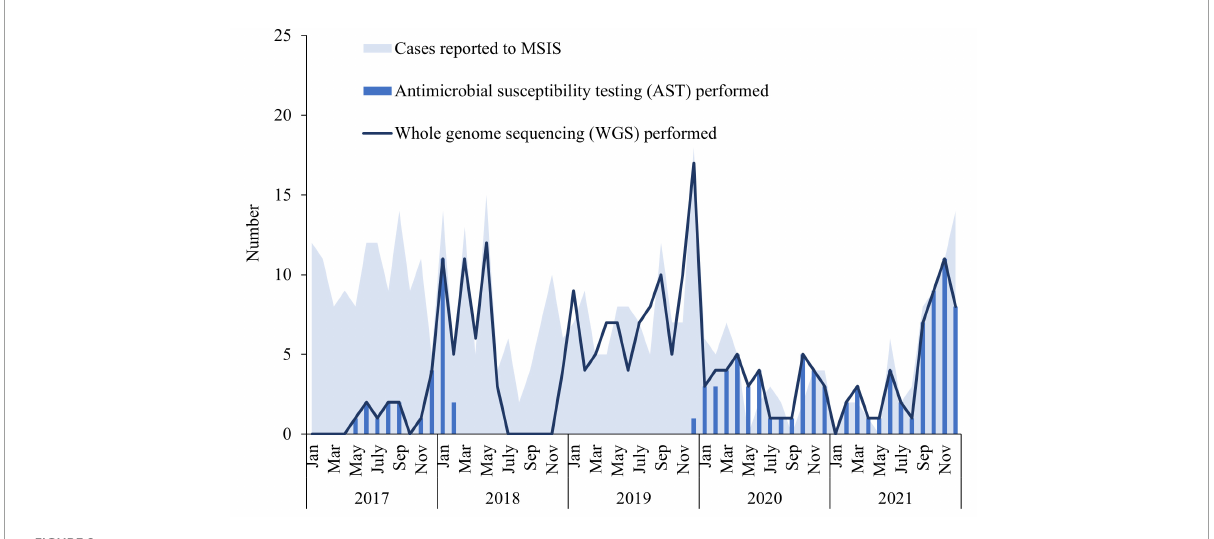
FIGURE2 Number of cases of invasive Haemophilus influenzae disease reported to the Norwegian Surveillance System for Communicable diseases (MSIS) at the Norwegian Institute of Public Health (NIPH) by month in Norway 2017–2019 (blue shaded area, N = 407), compared to the number of isolates whole-genome sequenced at the national reference laboratory at NIPH included in this study (dark blue line, N = 245) and the number of isolates for which antimicrobial testing was performed (blue bars, N =